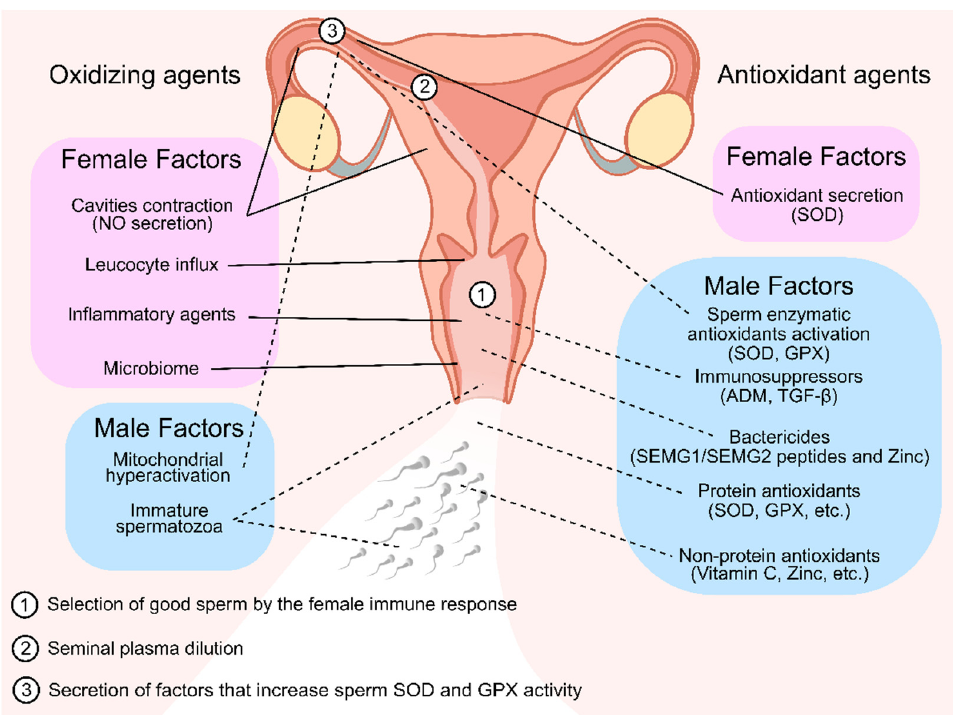
Figure 4. Oxidizing and antioxidant agents of seminal plasma and female reproductive tract fluid that are linked with selecting or protecting the sperm cells throughout their journey to fertilization.